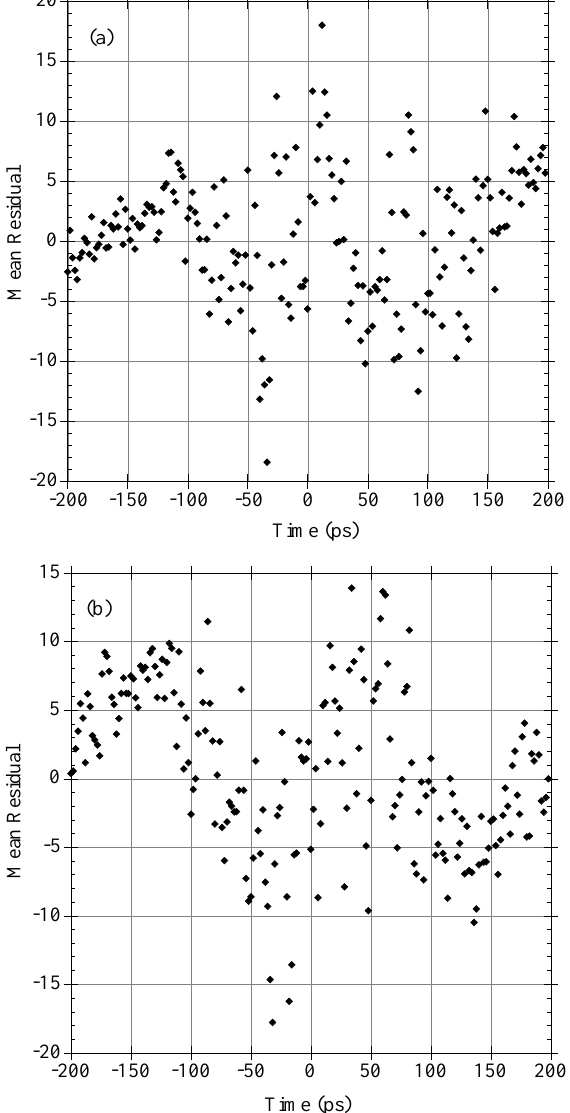
FIG. 23. The mean residual with the instability (a) present and (b) not